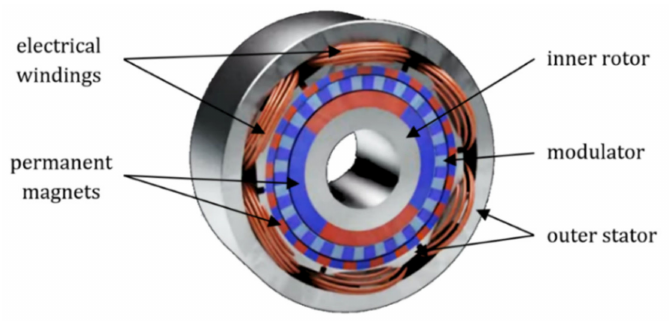
Figure 2. Pseudo direct drive (PDD) patented by Magnomatics